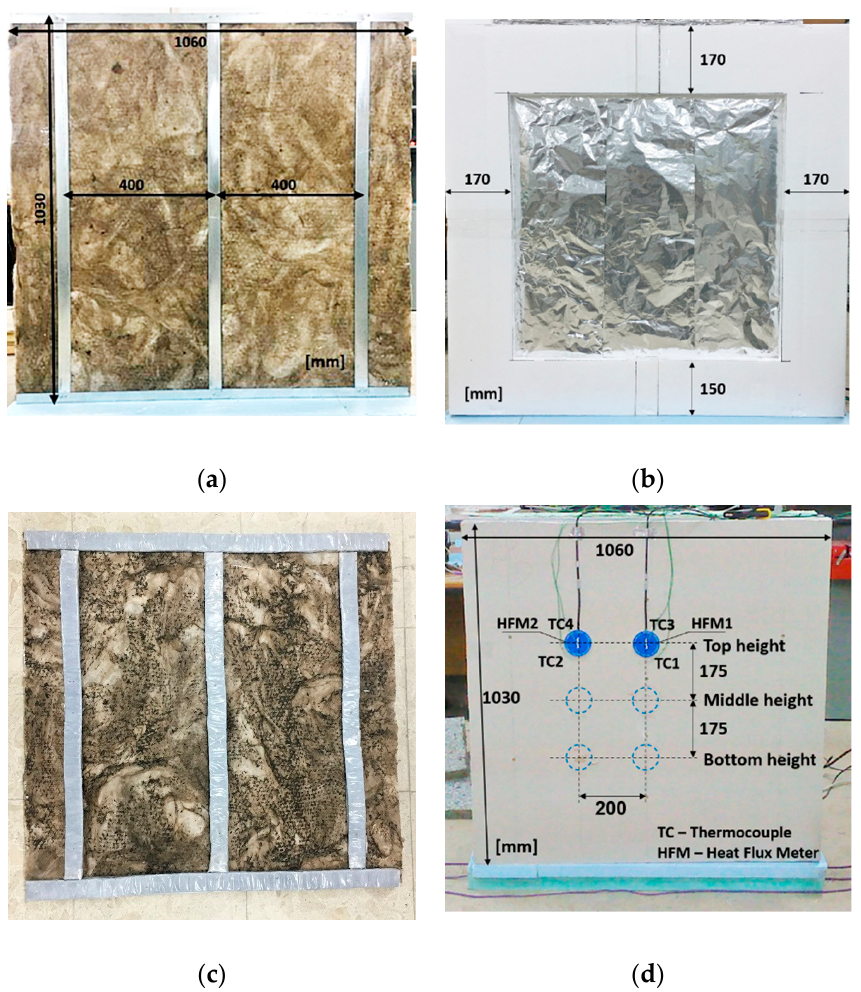
Figure 4. Double-pane LSF wall test sample: ( a ) LSF wall pane (hot side); ( b ) EPS frame and reflective foil; ( c ) aerogel TB strip; ( d ) arrangement of the monitoring system (cold side).